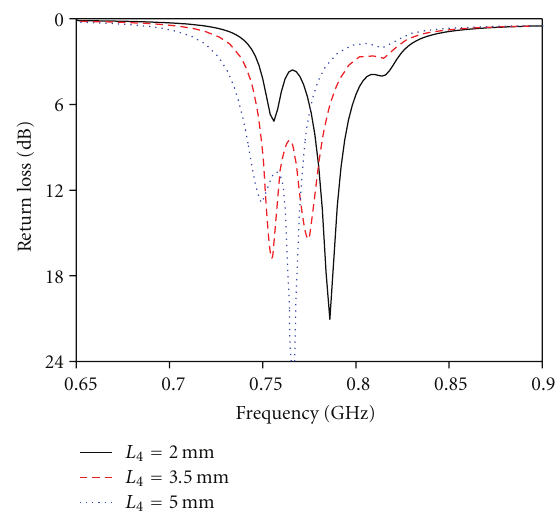
Figure 5: Return loss of the antenna with respect to a variation in the coupled feed strip length ( 𝐿 4 ).